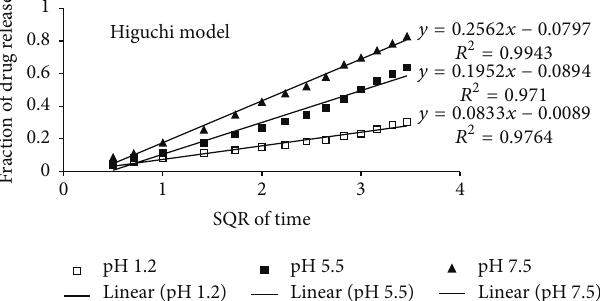
Figure 17: % cumulative pheniramine maleate release versus Sq. Rt. time (Higuchi model) from EGDMA cross-linked AA/Gelatin hydrogels.